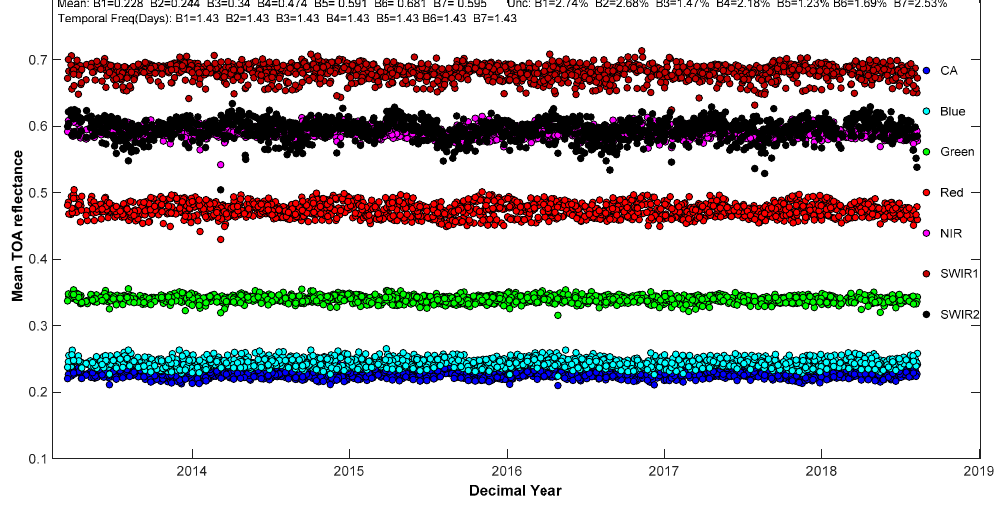
Figure 10. OLI lifetime TOA reflectance trend of Cluster 13.